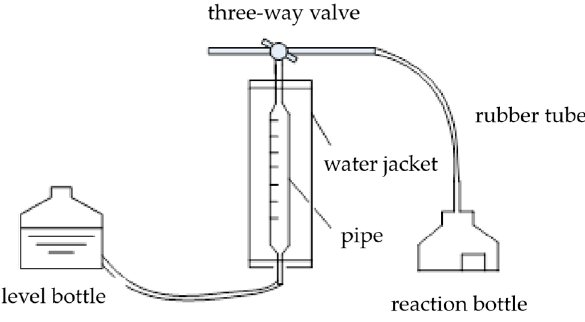
Figure 3. Amine load titration system.